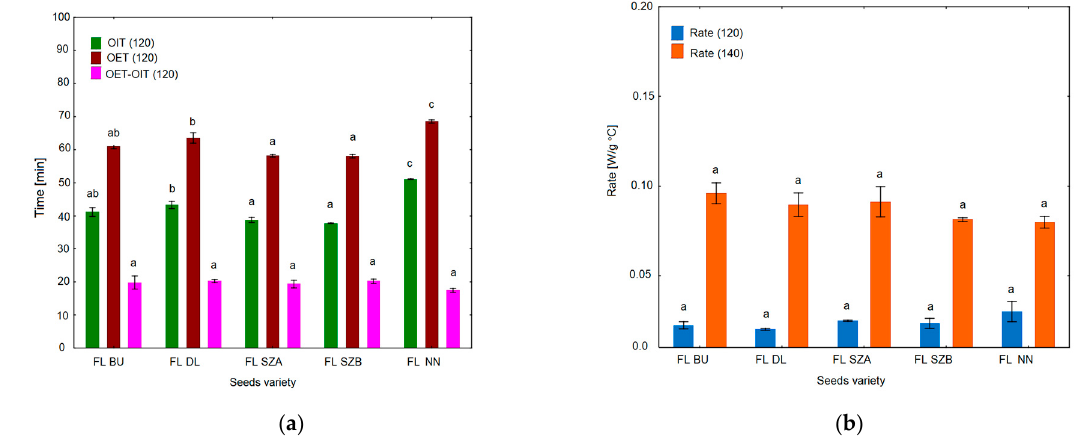
Figure 4. Oxidative stability parameters of five cold ‐ pressed flaxseed oils determined isothermally by DSC at 120 °C: ( a ) Oxidation induction time OIT (min), oxidation end time OET (min), the oxidation duration Δ t (min). ( b ) Rate of oxidation at 120 and 140 °C. Different letters (a, b, c) indicate significant differences ( p < 0.05). FL BU (Bukoz Flaxseed cultivar), FL DL (Dolguniec Flaxseed cultivar), FL SZA, FL SZB (Szafir Flaxseed cultivar), FL NN (Unknown Flaxseed cultivar).